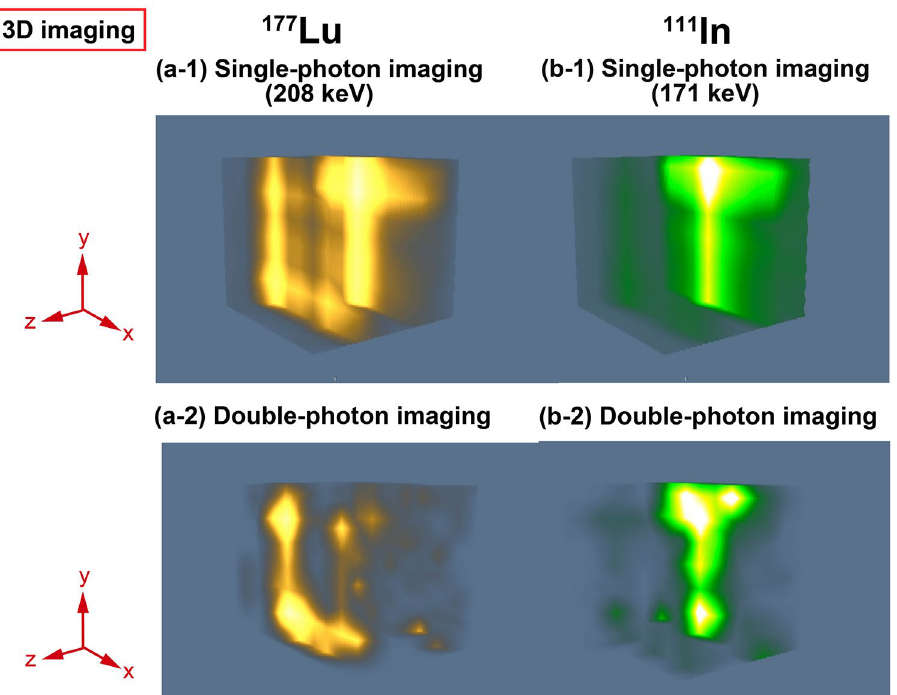
Figure 4. 3D imaging results of the distribution sources. The RI source of 111 InCl 3 was in an acrylic case of the alphabetical letter “T,” while the RI source of 177 LuCl 3 was in an acrylic case of the alphabetical letter “U”. ( a-1 ) 3D image of 111 In by single-photon BP imaging using 171 keV gamma rays. ( a-2 ) 3D image of 111 In by double- photon coincidence imaging. ( b-1 ) 3D image of 177 Lu by single-photon BP imaging using 208 keV gamma rays. ( b-2 ) 3D image of 177 Lu by double-photon coincidence